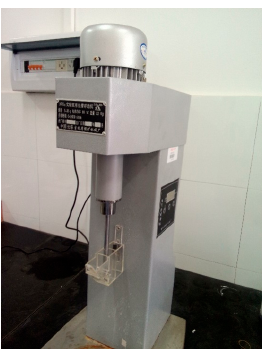
Figure 2. XFG flotation machine for a pure mineral flotation test.